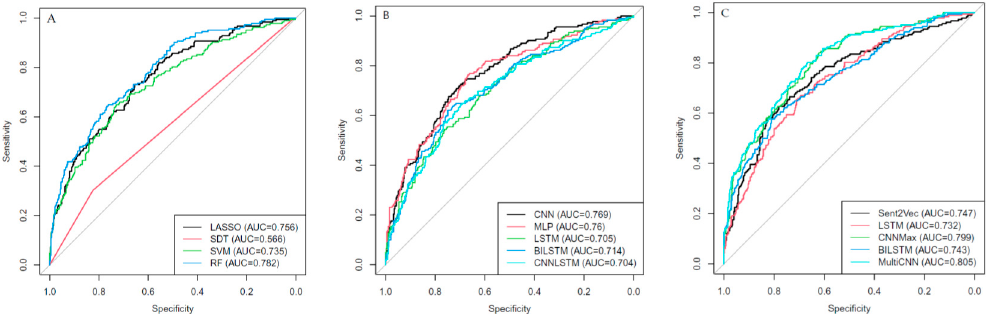
Figure 3. Results of the area under the receiver operating characteristic curves showing the performance of the word-level ML approach ( A ), DL approach ( B ), and ( C ) sentence- or document-level DL approach to predict poor outcome brain MRI texts (LASSO, least absolute shrinkage and selection operator; SDT, single decision tree; SVM, support vector machine; RF, random forest; CNN, convolutional neural network; MLP, multilayer perceptron; LSTM, long short-term memory; BILSTM, bidirectional LSTM; Sent2vec, CNN-Max, max-pooling CNN; Multi-CNN, multi-kernel CNN; AUC, area under the receiver operating characteristic